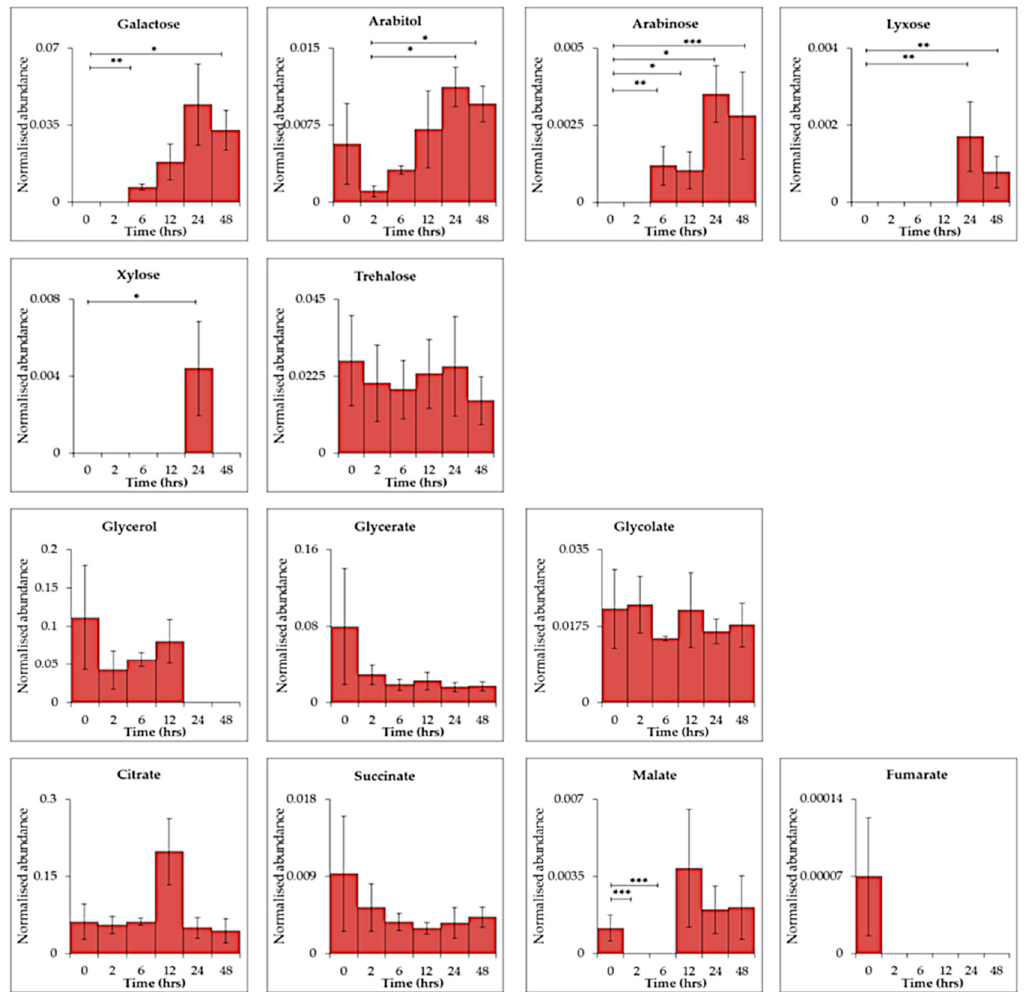
Figure 4. Time-series exometabolomics data of C. fritschii over 48 h of UV-B exposure showing primary metabolites found in extracellular samples only. Statistical significance was measured using a two-sample T-test comparing control (0 h) and UV-B exposure (2, 6, 12, 24 and 48 h) and between each treatment time point, * = 0.05 ≥ p ≥ 0.01, ** = 0.01 ≥ p ≥ 0.001 and *** = p ≤ 0.001.